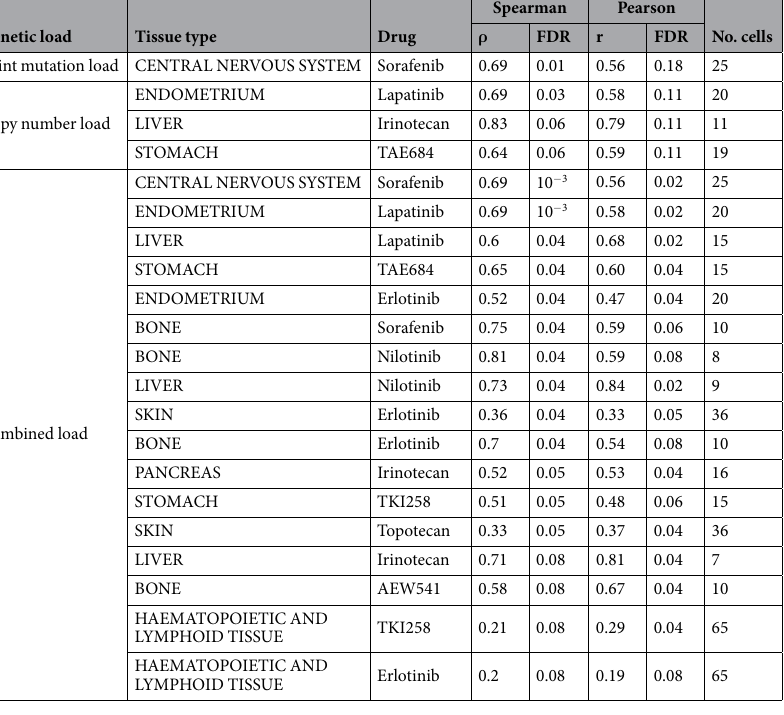
Table 4. Significant associations for tissue-drug The impact of the genetic load on gene expression.